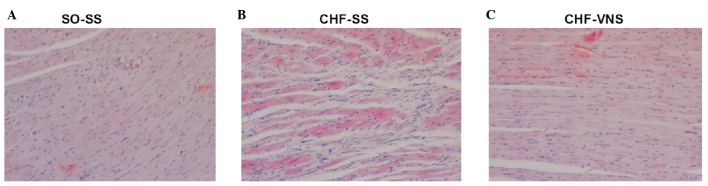
Photomicrographs (magnification, x100) of hematoxylin and eosin staining of infarcted regions of left ventricle cross-sections. (A) SO-SS treatment for 72 h caused no obvious pathological change, the myocardial striations, intercalated discs and cell nuclei were clearly stained, the cardiomyocytes exhibited regular shape and arrangement with a clear edge, and the cytoplasm and nuclei were stained evenly. In addition, the cardiac myofibers were tightly connected and the interstitial fibroblasts displayed no morphological abnormality (n=5). (B) CHF-SS treatment for 72 h caused cardiomyocytes to exhibit an irregular morphology and arrangement. The cytoplasm was unevenly stained with irregular granules, the nuclei were condensed and darkly stained. In addition, myofibers swelling, interstitial edema and red blood cell leakage were also observed (n=9). (C) CHF-VNS treatment resulted in cardiomyocytes being notably disorganised, the myocardial cells were arranged relatively neatly, the intercalated discs and nucleus appeared more clear (n=9). SO, sham-operation; SS, sham stimulation; CHF, chronic heart failure; VNS, vagal nerve stimulation.